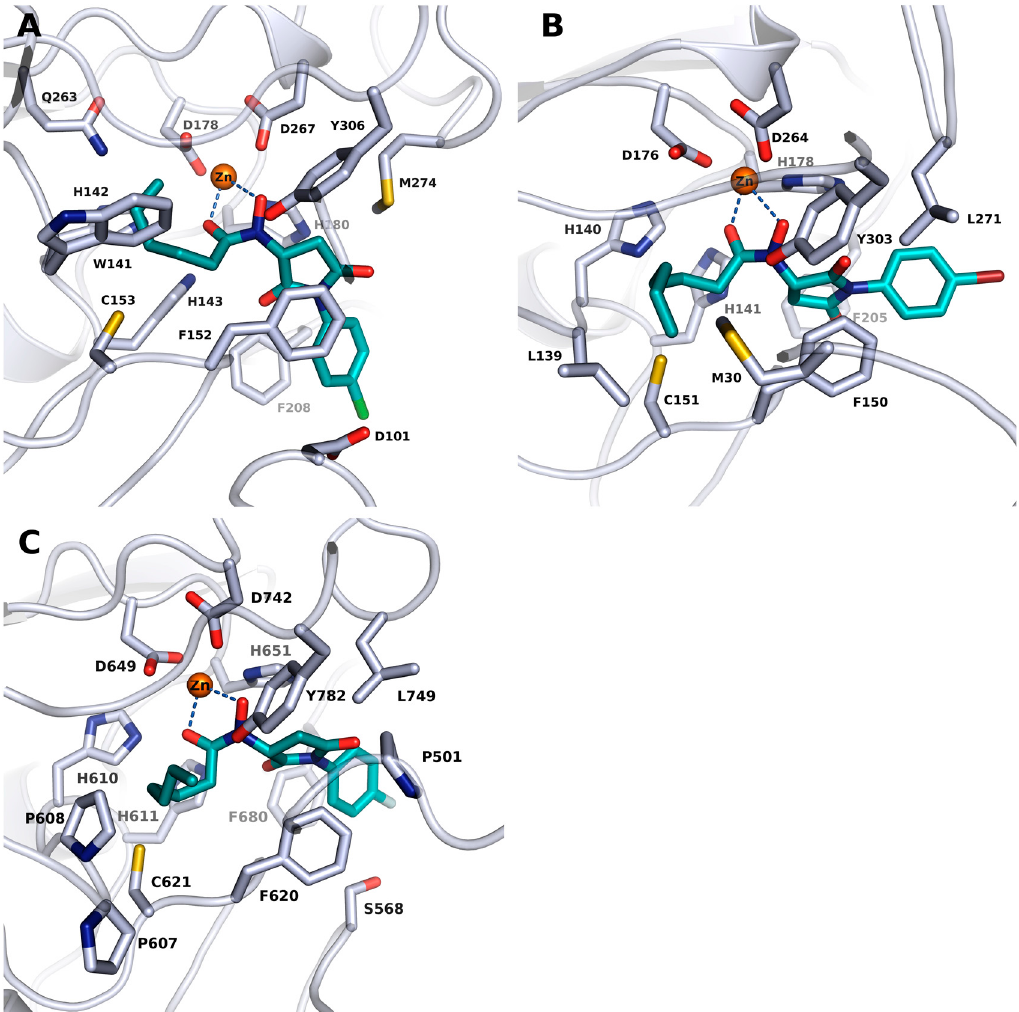
Figure 3. Docking poses of J1036, J1063 and J1064 in the human HDAC8 ( A ), HDAC1 ( B ) and CD2 HDAC6 ( C ) isoforms, respectively. Ligands are shown in cyan while the protein backbones are shown as ribbons and side chains of key amino acid residues in their respective active sites are shown as white sticks. Catalytic zinc ion is shown as an orange sphere. Coordination of the zinc ion is represented with light blue lines.